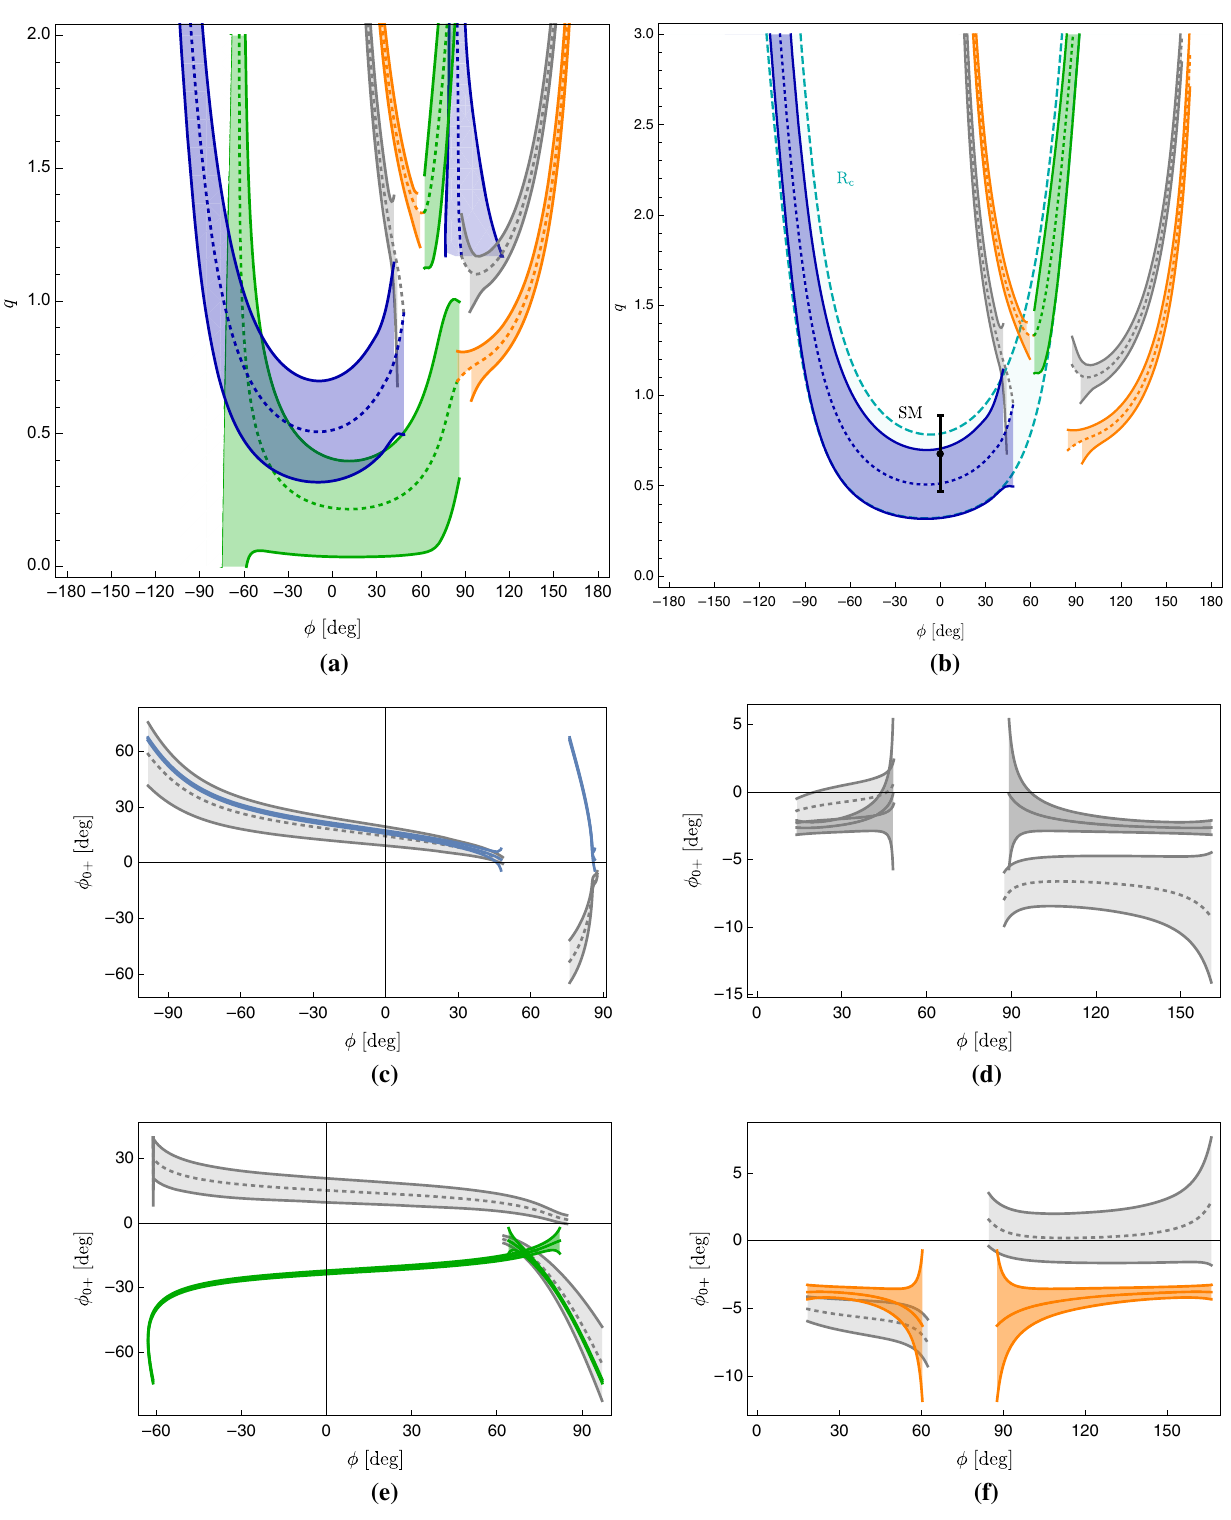
Fig. 11 a Contours in the φ – q plane for the current data for the charged B → π K decays. b Contours remaining after imposing the constraints discussed in the text. c – f Theory constraints (grey) combined with the φ 0 + constraint following from the triangle constructions in the same